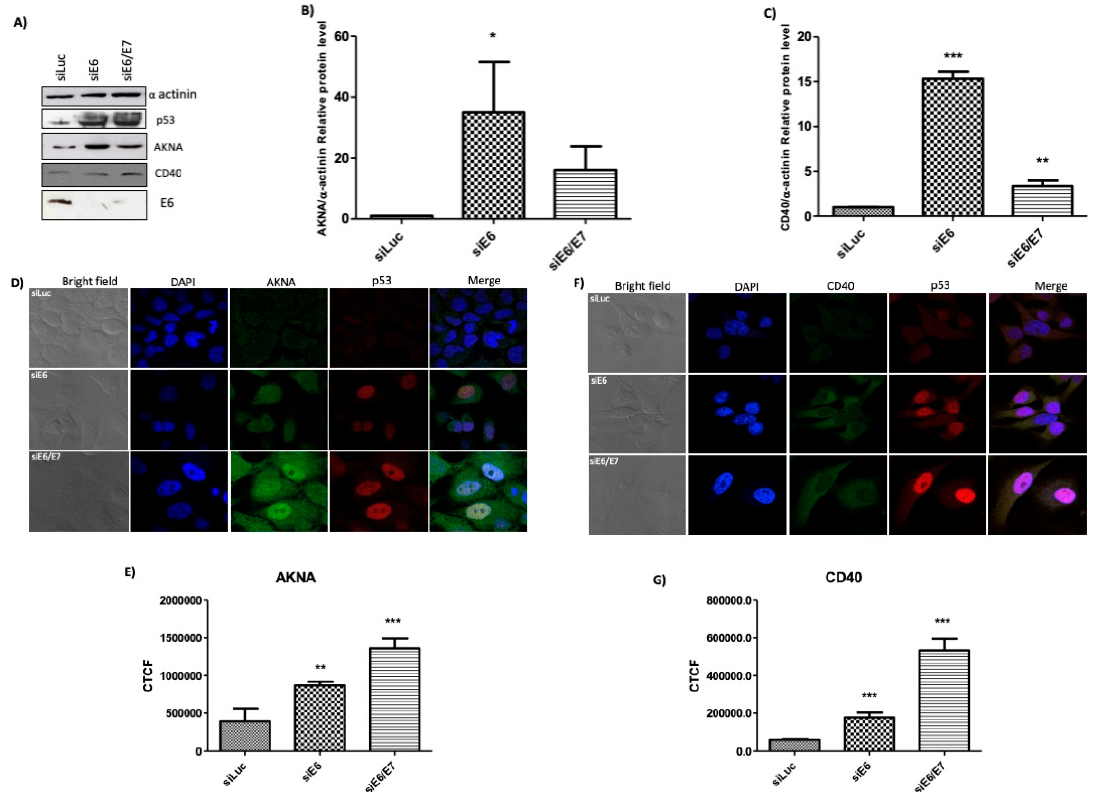
Figure 5. E6 regulates the expression levels of AKNA and CD40 in the HPV positive cell line HeLa. HeLa cells were seeded in a 60 mm dishes and transfected with siRNAs directed against E6, siE6/E7 and Luciferase (siLuc) as an unspecific control. After 72 h cells were either fixed or collected and total protein extracted using sample buffer. ( A ) Levels of AKNA and CD40 were evaluated by western blot using specific antibodies, α -actinin was used as a loading control, and p53 was evaluated to assess the silencing efficiency of E6. Cells showed a clear increase in p53 levels indicating the efficient ablation of E6 expression and, in cells were p53 was restored showed also an increase in AKNA and CD40 levels. Densitometric analysis expressing data as the ratio of relative units between AKNA/ α -actinin ( B ), and CD40/ α -actinin ( C ). Data are shown as the mean ± SD. Tukey’s test * p < 0.05, ** p < 0.001 and *** p < 0.0001 vs. pCA control. n = 3. ( D , F ) Fixed HeLa cells were stained for immunofluorescence analysis using anti-CD40, AKNA anti-serum and anti-p53 antibody followed by secondary Alexafluor antibodies as specified, finally cells were mounted using Prolong DAPI media (Molecular Probes) and observed in a confocal NIKON Eclipse Ti microscope. E6 knocked down cells exhibited p53 positive signal due to E6 inactivation, p53 positive cells showed a clear accumulation of AKNA in the cytoplasm and in the nucleus as well as a co-localization with p53. CD40 showed an increase in the siE6 and siE6/E7 cells mainly in the cytoplasm. All images were acquired under the 40 × objective using a NIKON camera. ( E , G ) AKNA and CD40 fluorescence quantification using the corrected total cell fluorescence (CTCF) method. Data are shown as the mean ± SD. Student’s t -test ** p < 0.01 and *** p < 0.0001 vs. siLuc control. n =